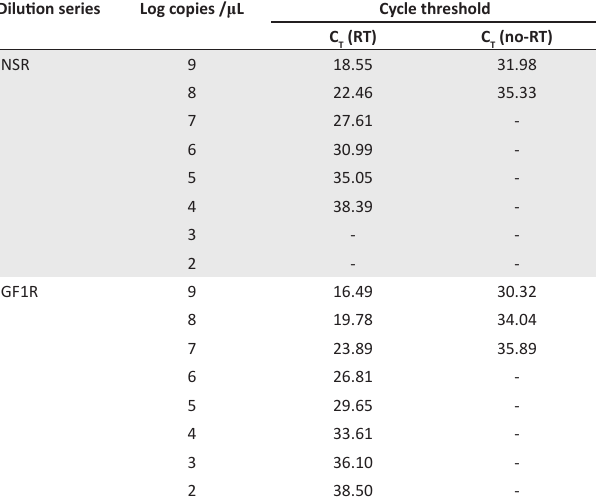
TABLE 2: Comparison between RT and no-RT controls, using cycle threshold (CT) values of an IGF1R and INSR dilution series.